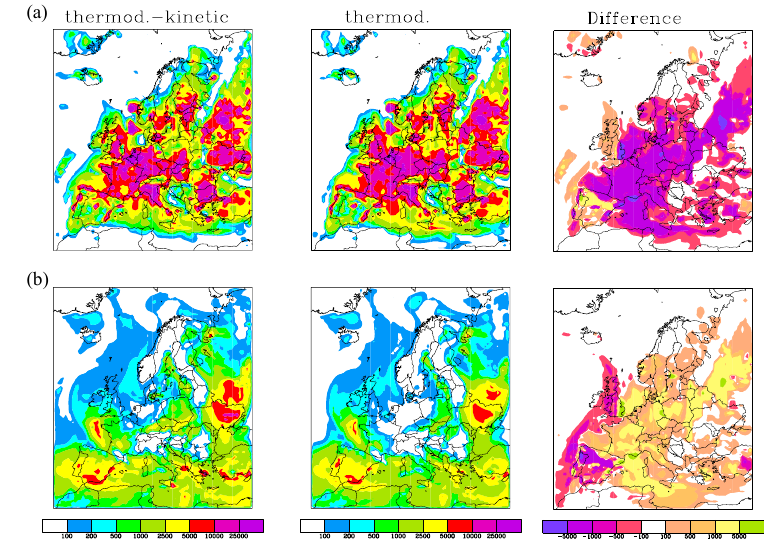
Fig. 8. Modelled near-surface particle number concentration [cm − 3 ] in (a) the Aitken and (b) the accumulation mode on 22 June 2010, 18:00UTC over Europe. The difference is determined by subtraction of the thermodynamic data from the mixed thermodynamic-kinetic Figure 8. Modelled near surface particle number concentration [1/cm 3 ] in (a) the Aitken and 17 data. (b) the accumulation mode on 22.06.2010, 18 UTC over Europe. The difference is determined 18 by subtraction of the thermodynamic data from the mixed thermodynamic-kinetic data. 19 20